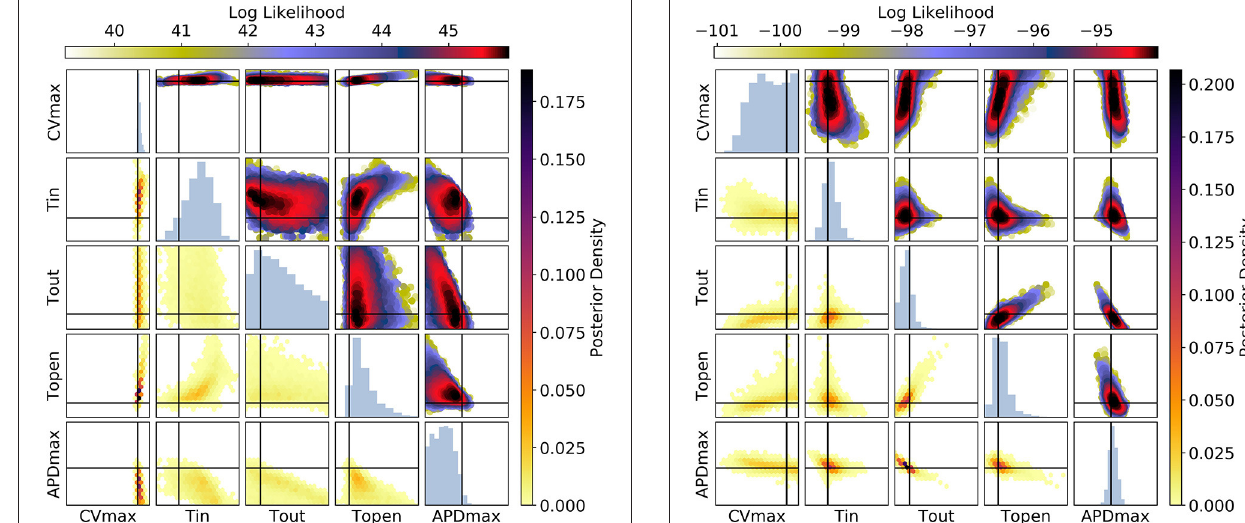
FIGURE 11 | The posterior parameter distribution for fits to APD(S2) and ERP(S1) measurements. The intersection of vertical and horizontal lines mark the true parameter value. The lower diagonal shows the density via hexbin plots, while the upper diagonal shows the log-likelihood values for each sample plotted in order of increasing likelihood. The diagonals show the marginal histograms of each